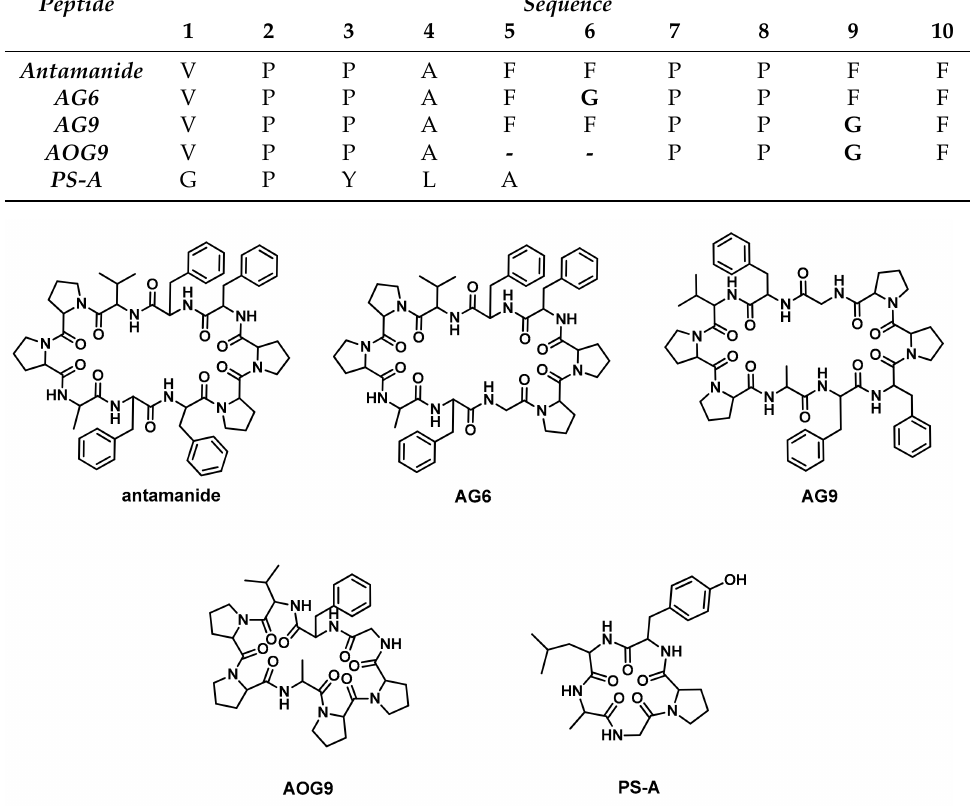
Figure 1. Chemical structure of the investigated cyclic